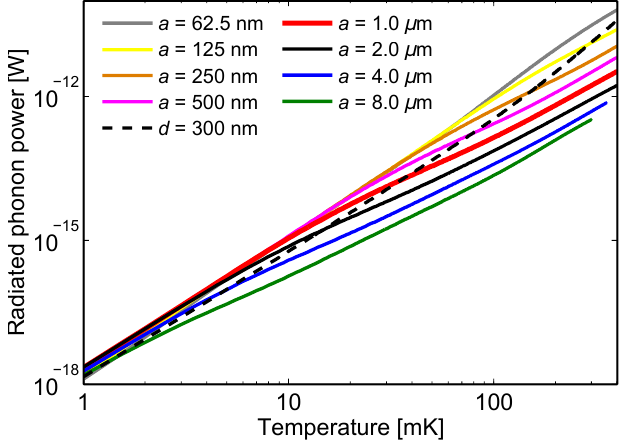
Figure 2. Radiated phonon thermal power for a selection of different phononic crystals (PnC) membranes with a square lattice hole pattern of period a = 62.5 nm – 8 µ m, and a full membrane with the same thickness d = 300